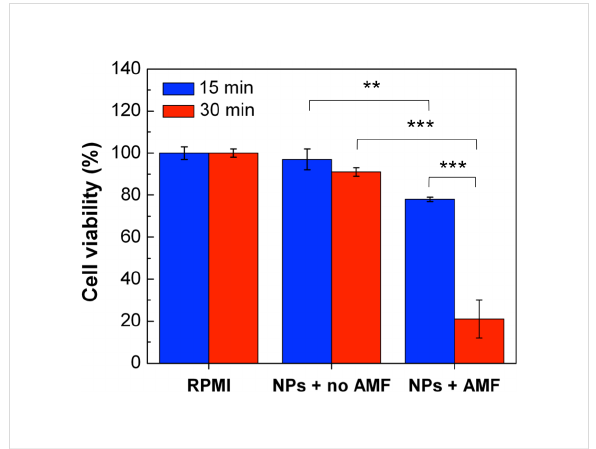
Figure 7: Cell viability study (MTS assay) of 4T1 cells after 15 and 30 min incubation with NPs during AMF exposure or without its appli- cation. RPMI: viability of cells cultivated at 37 °C in cell medium with- out NPs; NPs + no AMF: viability of cells cultivated at 37 °C in the presence of MNP-25 in cell medium for 15 or 30 min; NPs + AMF: viability of cells cultivated in the presence of MNP-25 in cell medium for 15 or 30 min of AMF exposure (heating up to 46 ± 1 °C in 261–393 kHz, 25 mT AMF). The results are shown as the mean ± SD, ** p < 0.01, *** p < 0.001 (one-way